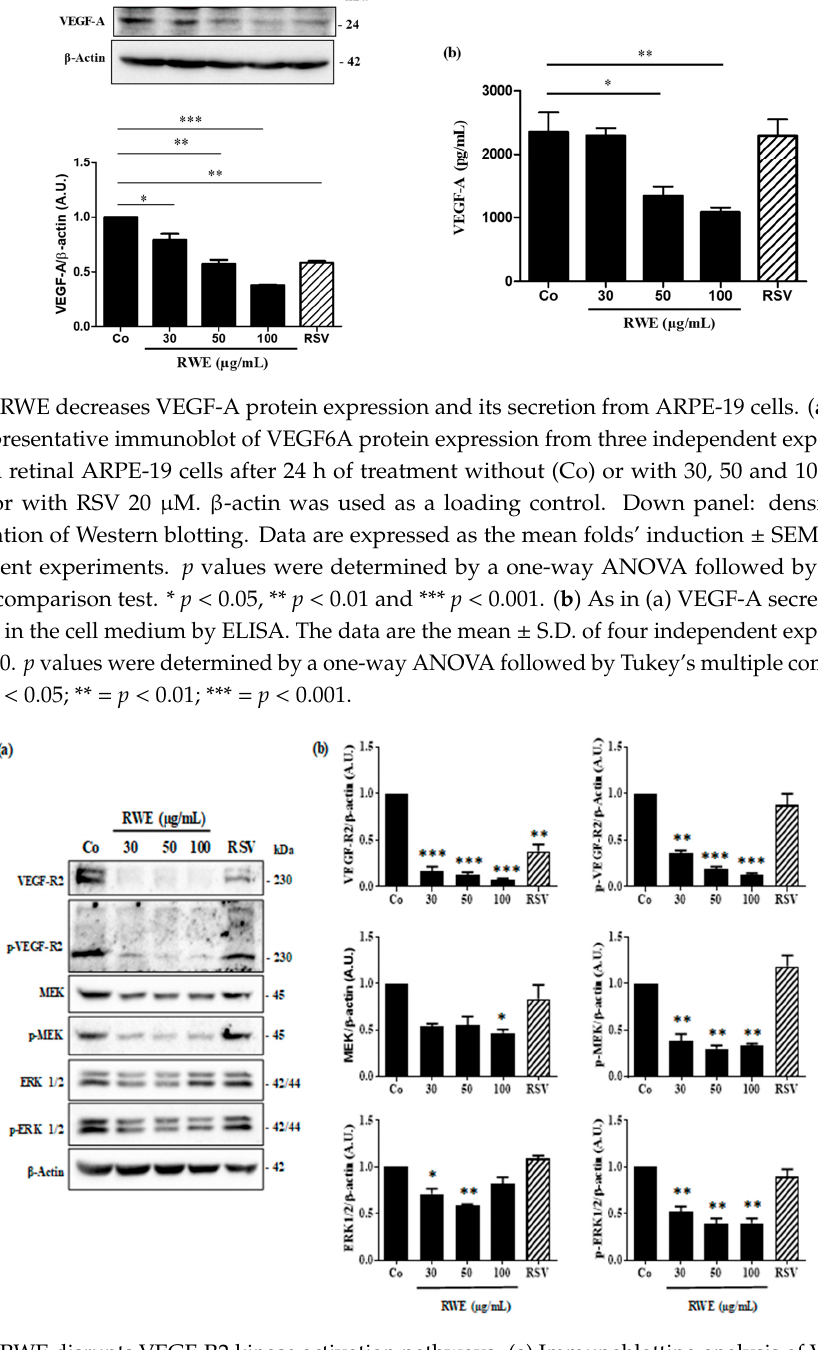
Figure 6. RWE disrupts VEGF-R2 kinase activation pathways. ( a ) Immunoblotting analysis of VEGF- R2, phospho VEGF-R2 ( p -VEGF-R2), MEK, phospho MEK ( p -MEK), ERK 1/2 and phospho-ERK 1/2 ( p phospho VEGF-R2 ( p -VEGF-R2), MEK, phospho MEK ( p -MEK), ERK 1 / 2 and phospho-ERK 1 / 2 ( p ERK 1 /